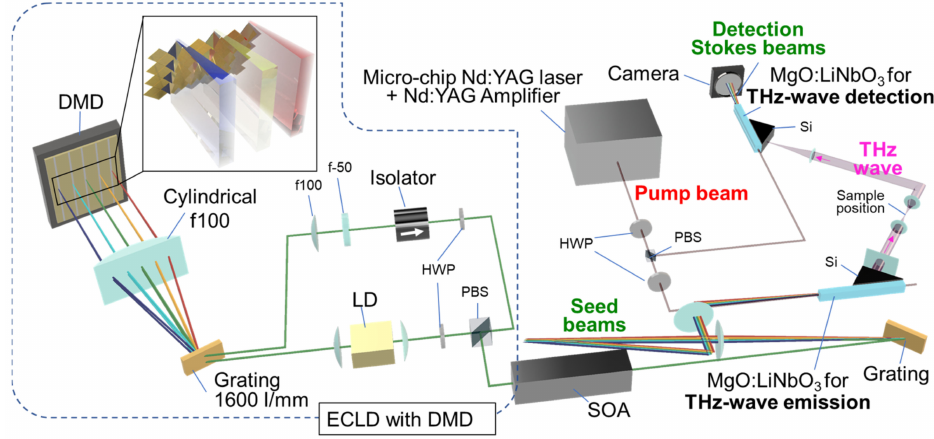
Figure 1. Multi-wavelength terahertz-wave parametric generator using multi-wavelength ECLD as an injection seeding